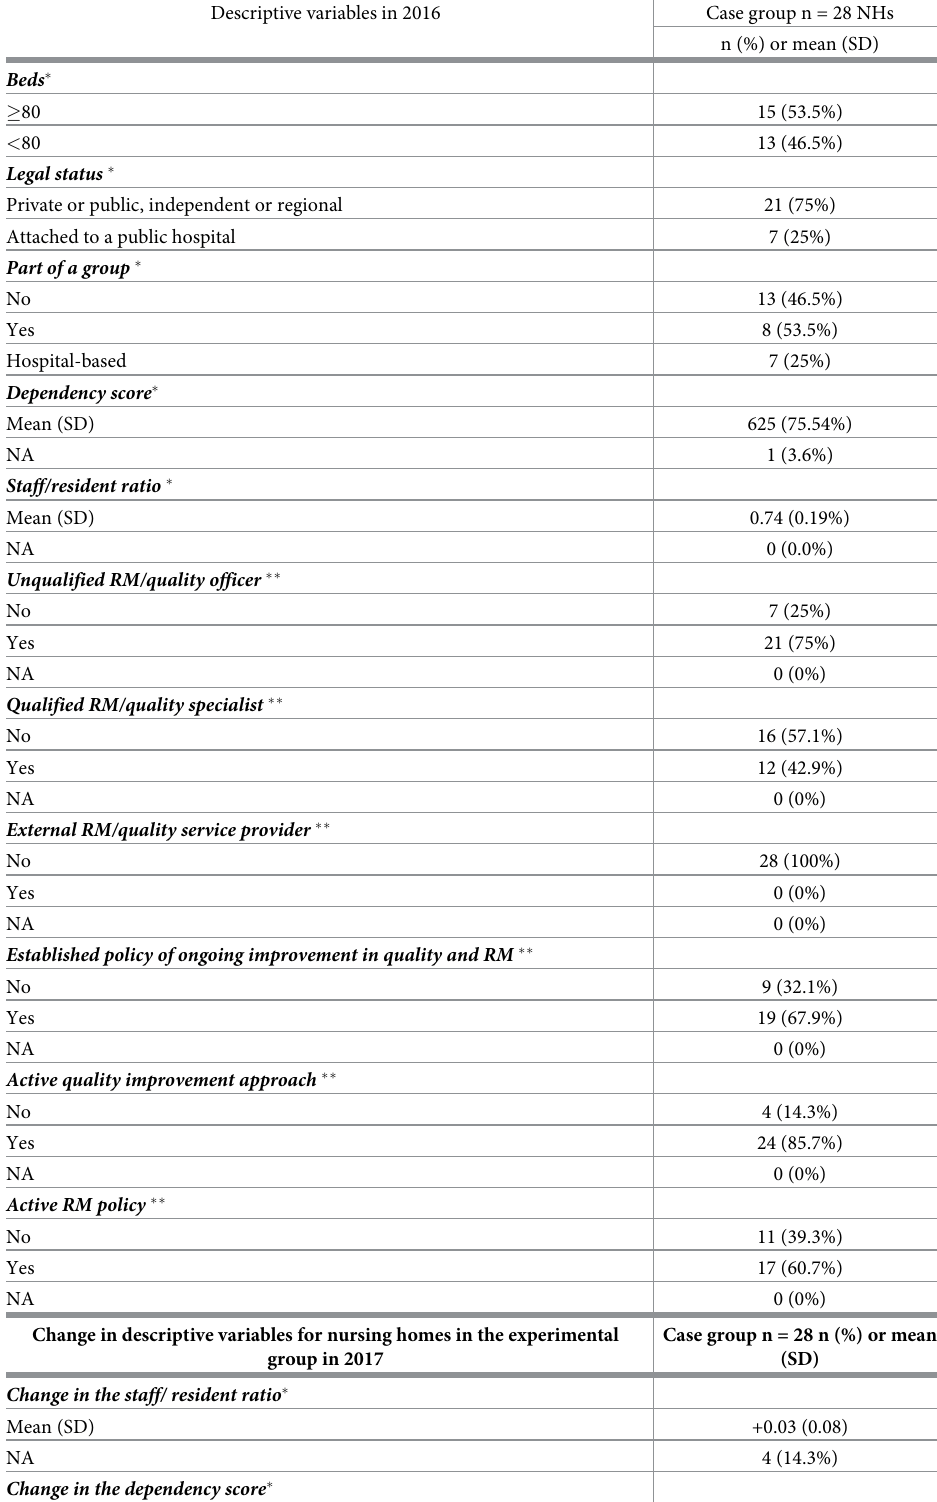
Table 2. Descriptive variables of nursing homes and the implementation of the